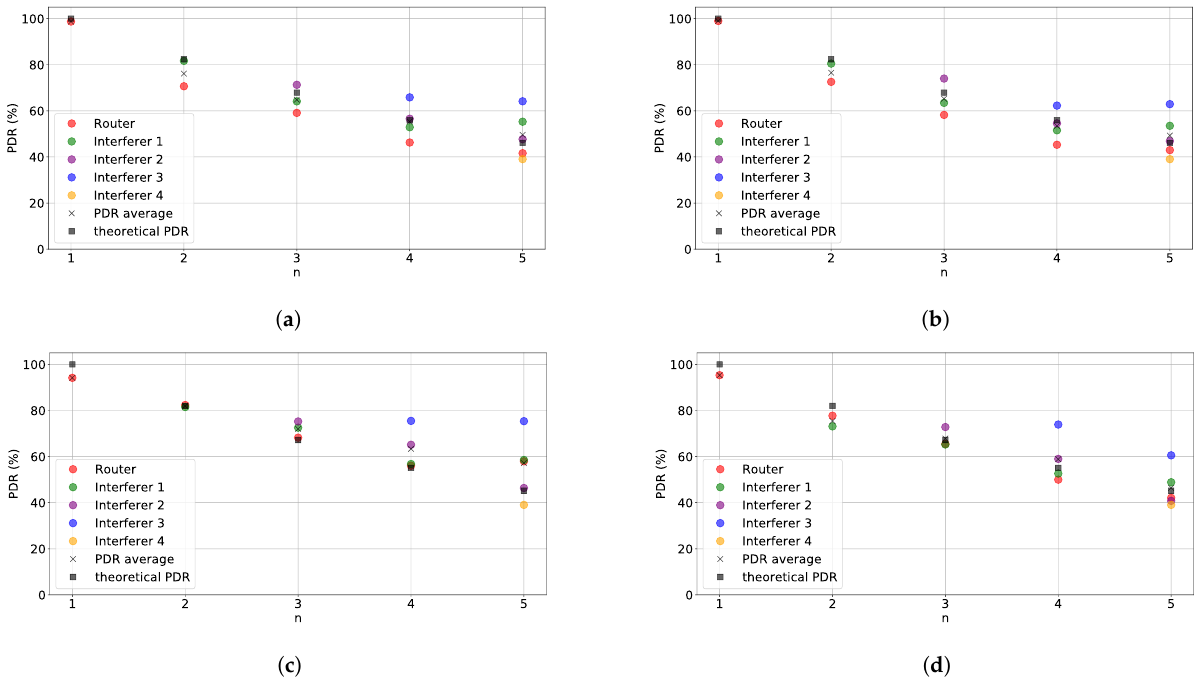
Figure 3. Performance evaluation results. Packet Delivery Rate (PDR) vs number of nodes in the network for different configurations: ( a ) Spreading Factor ( SF ) = 7, P tx = 0 dBm, ( b ) SF = 7, P tx = 14 dBm, ( c ) SF = 12, P tx = 0 dBm, and ( d ) SF = 12, P tx = 14 dBm.